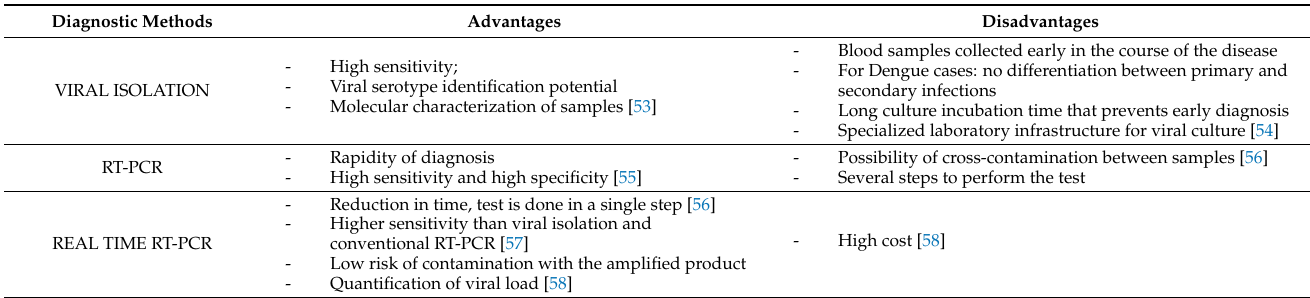
Table 1. Comparison between methods used for diagnosis of